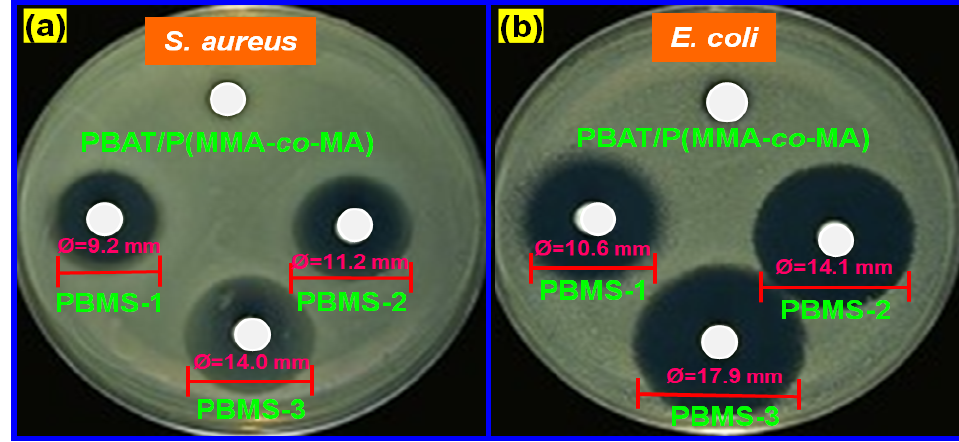
Figure 11. Antimicrobial test results of PBAT/P(MMA- co -MA) and their composite films against ( a ) S. aureus and ( b ) E. coli .